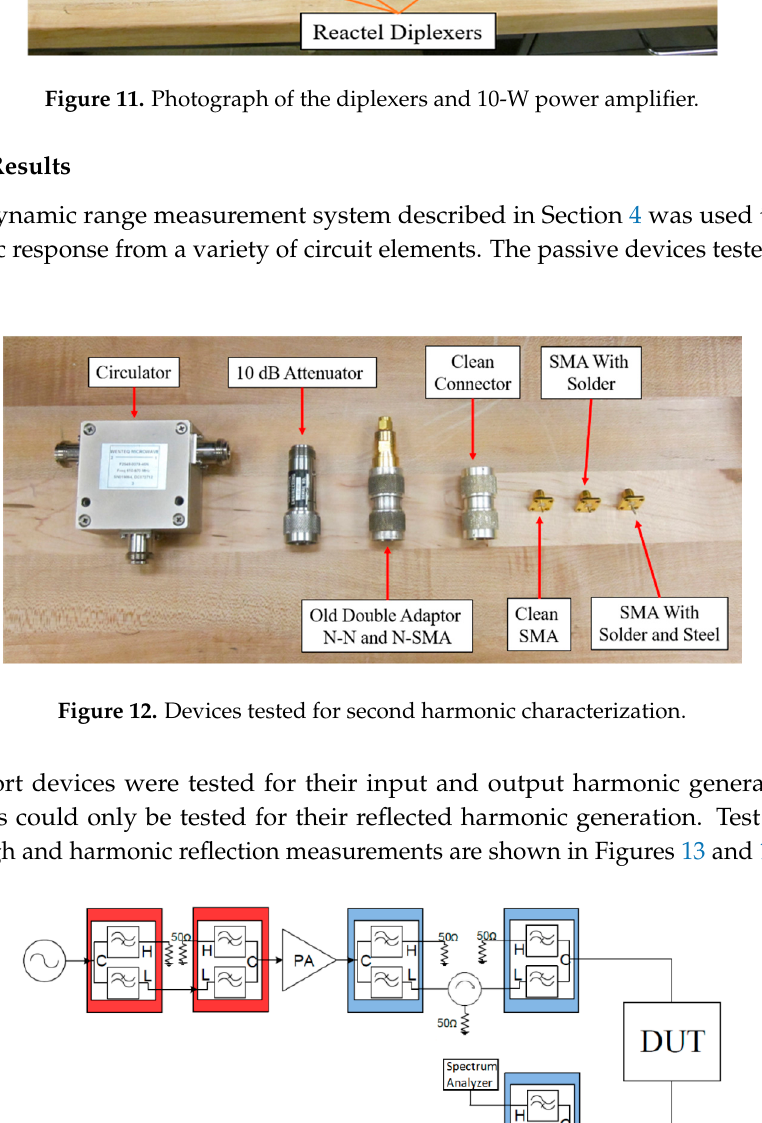
Figure 11. Photograph of the diplexers and 10-W power amplifier.